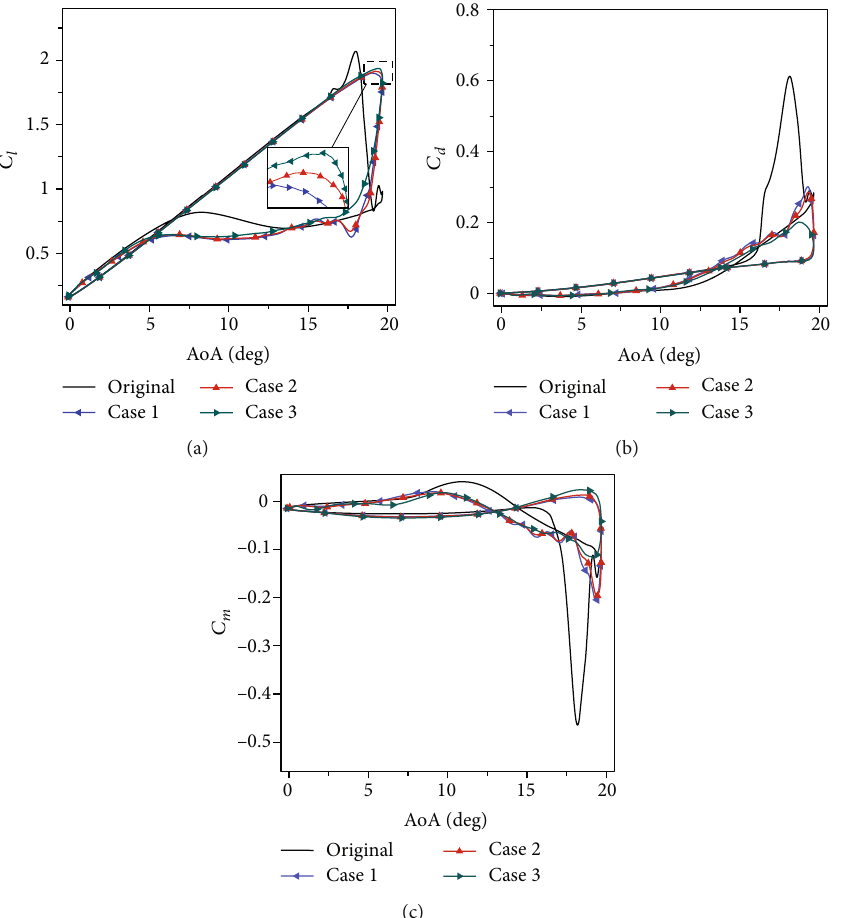
Figure 19: Comparison of aerodynamic coe ffi cients between di ff erent cases: (a) lift coe ffi cients, (b) drag coe ffi cients, and (c) pitching moment coe ffi